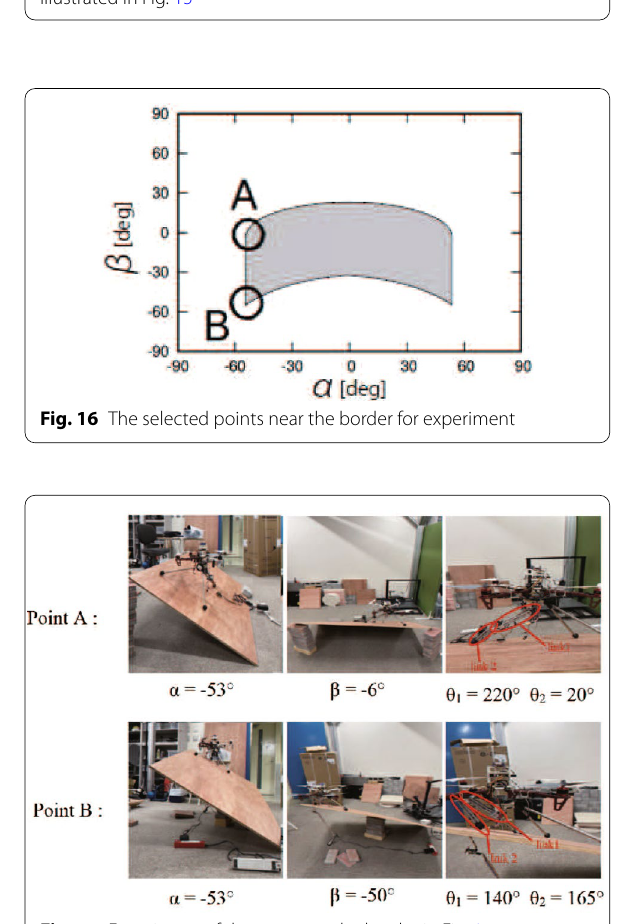
Fig. 17 Experiment of the area near the border in Fig. 9